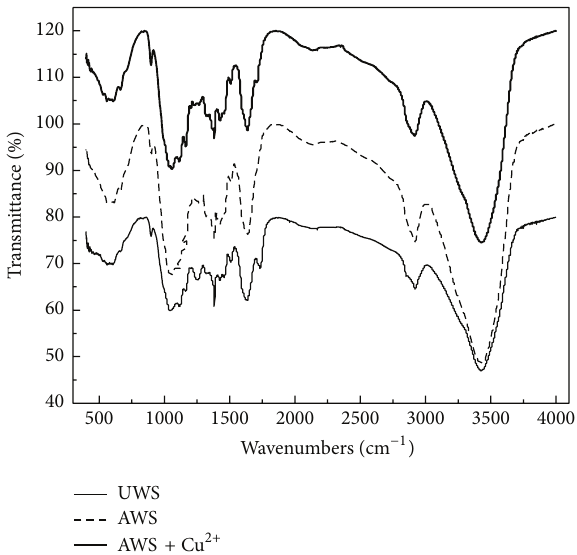
Figure 9: FTIR spectra of UWS and AWS and after adsorption of Cu(II) on AWS (AWS + Cu(II)).